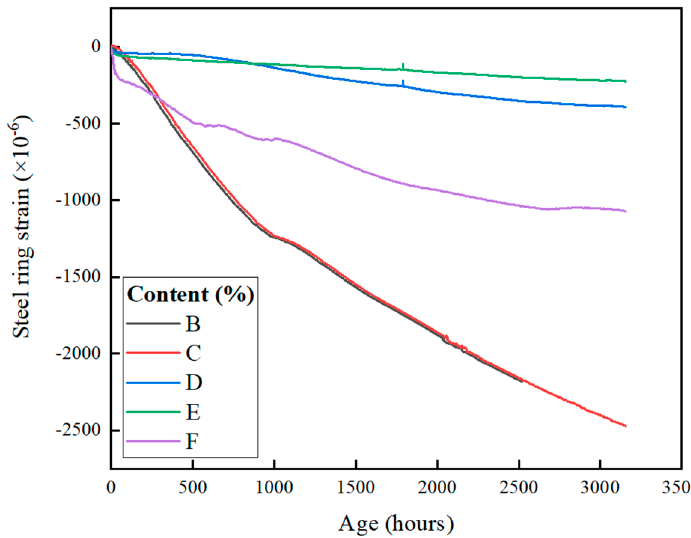
Figure 9. Steel ring strain of GGBFS geopolymers with SP added.